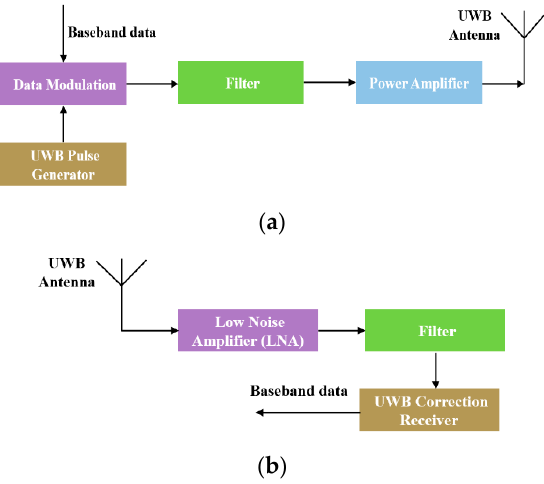
Figure 2. The typical block diagram of a UWB system ( a ) transmitter ( b ) receiver.